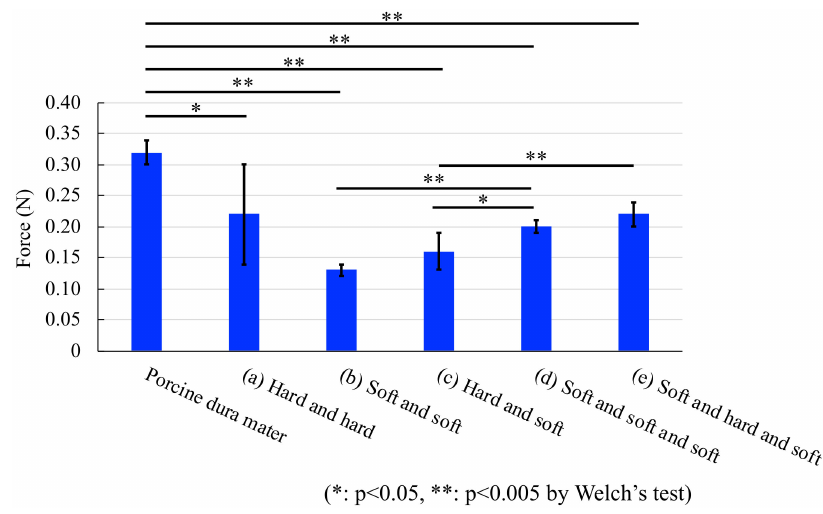
Figure 13. Experimental results of the microscissor tests.